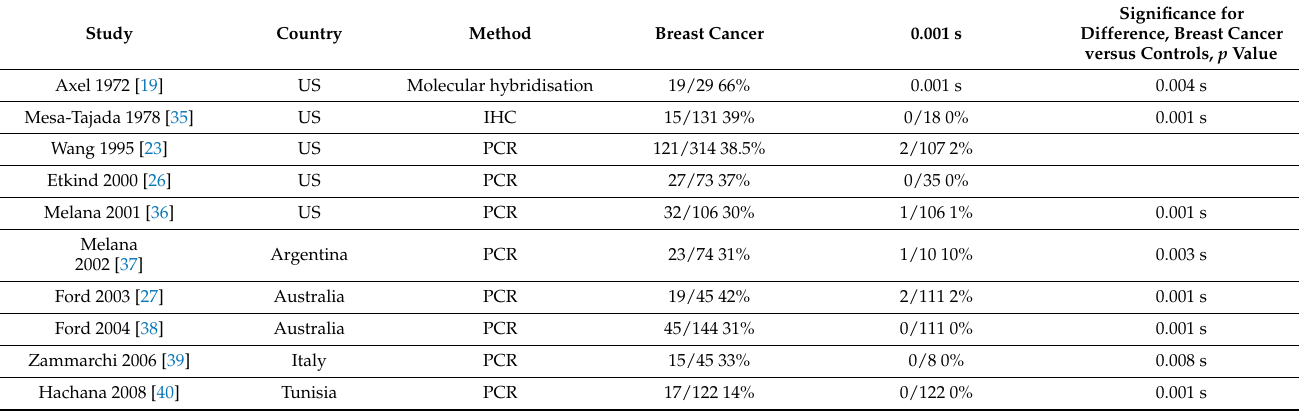
Table 1. MMTV positive breast cancer compared to benign and normal breast